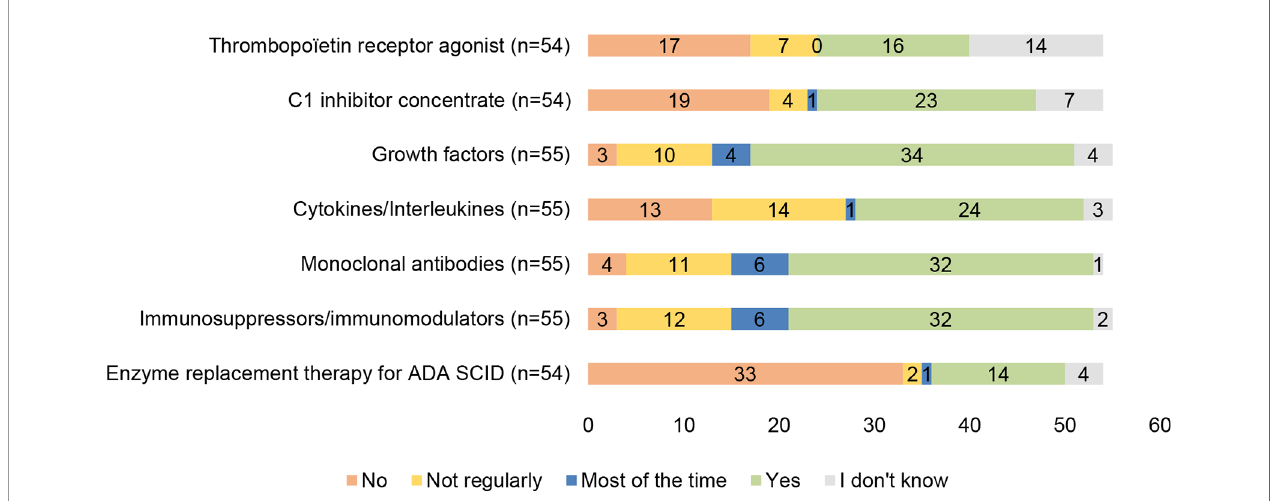
FIGURE 5 | Availability of other treatments for patients with PIDs in individual countries.